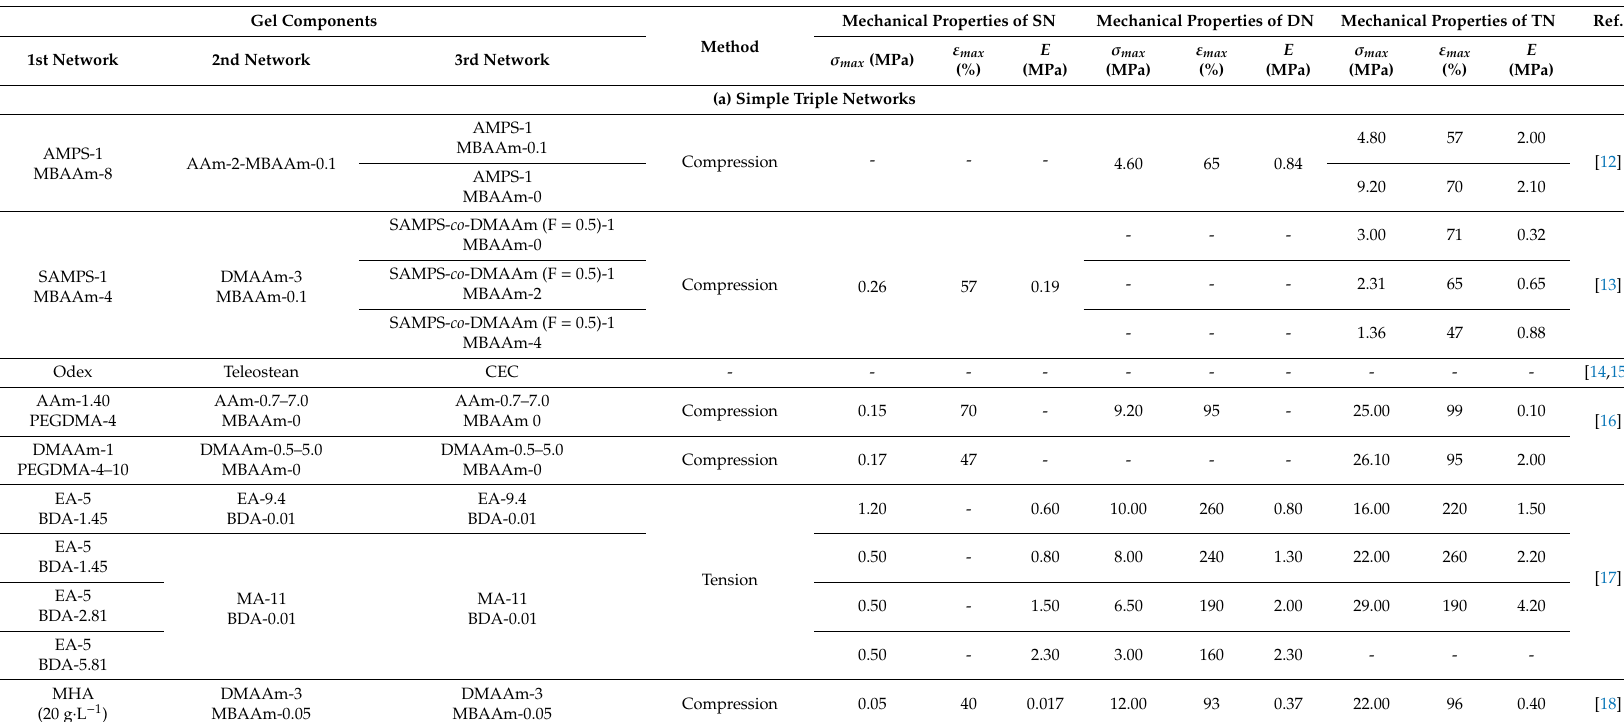
Table 1. Summary of all prepared triple-network (TN) hydrogels and their mechanical properties, fracture stress ( σ max ), fracture strain ( ε max ), and Young’s modulus ( E ), in comparison with the mechanical properties of their single-network (SN) and double-network (DN)